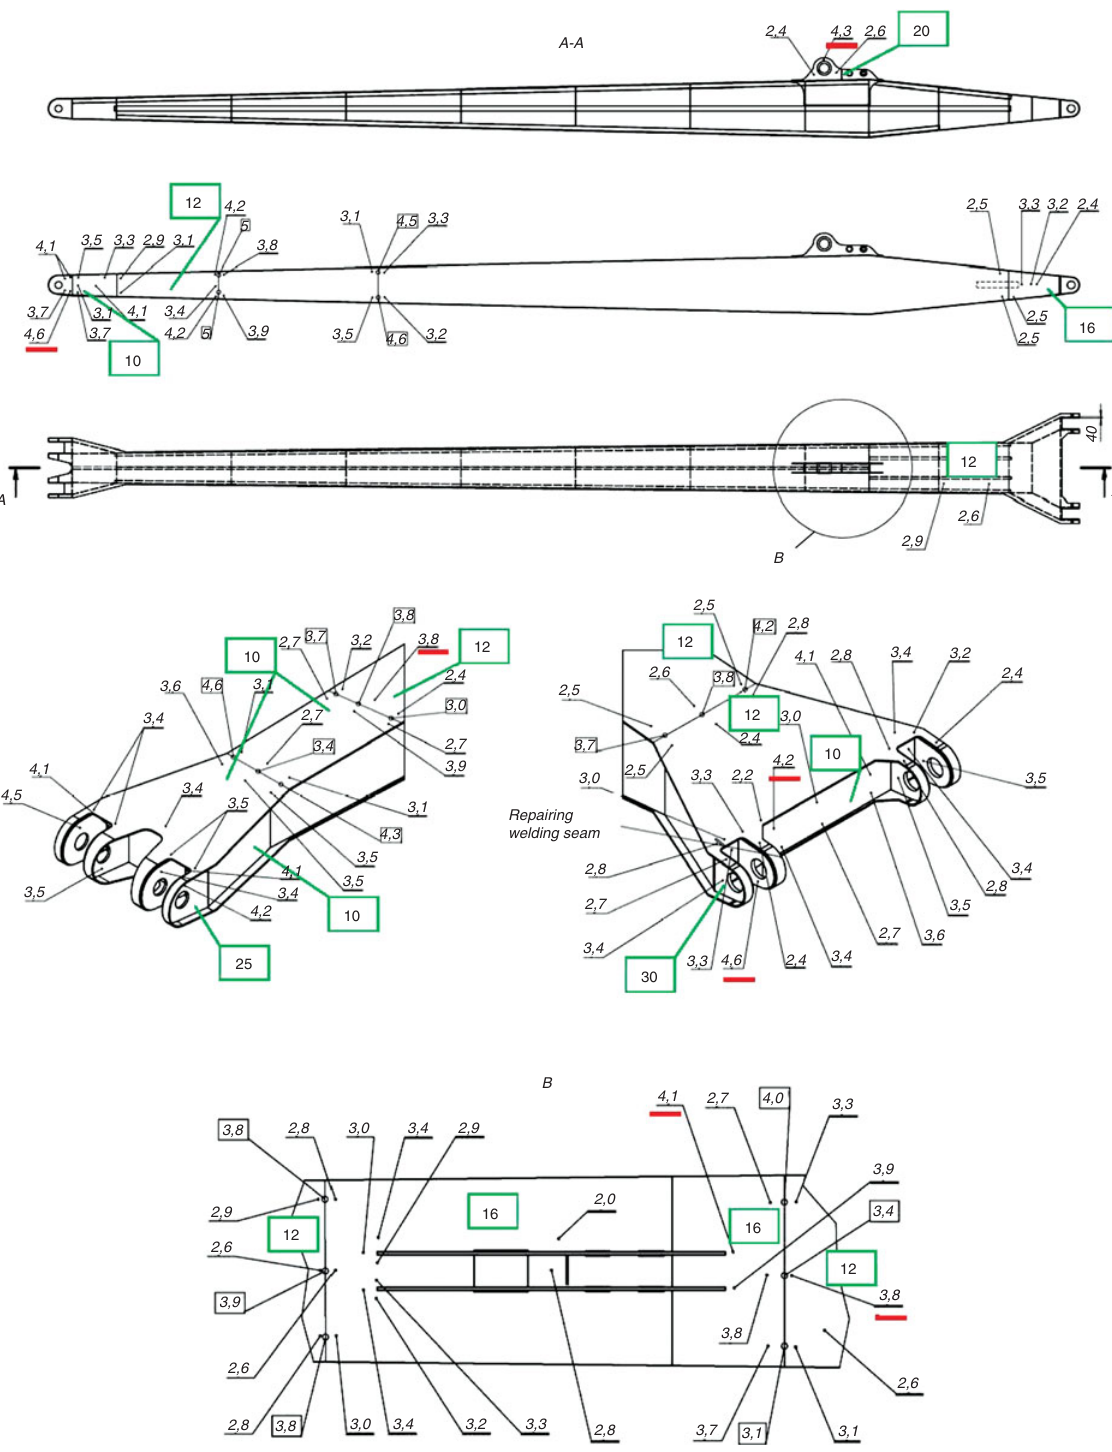
Fig. 2. Value of coercive force in the boom of portal